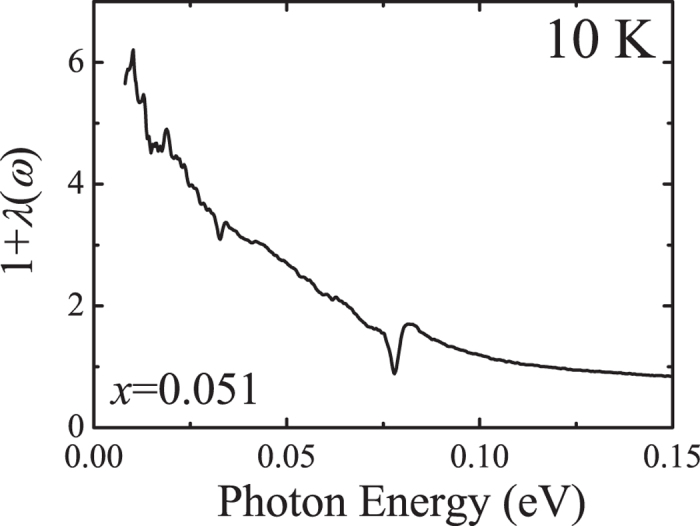
Mass enhancement of (Sr0.949La0.051)3Ir2O7 at 10 K calculated from the extended Drude model analysis.